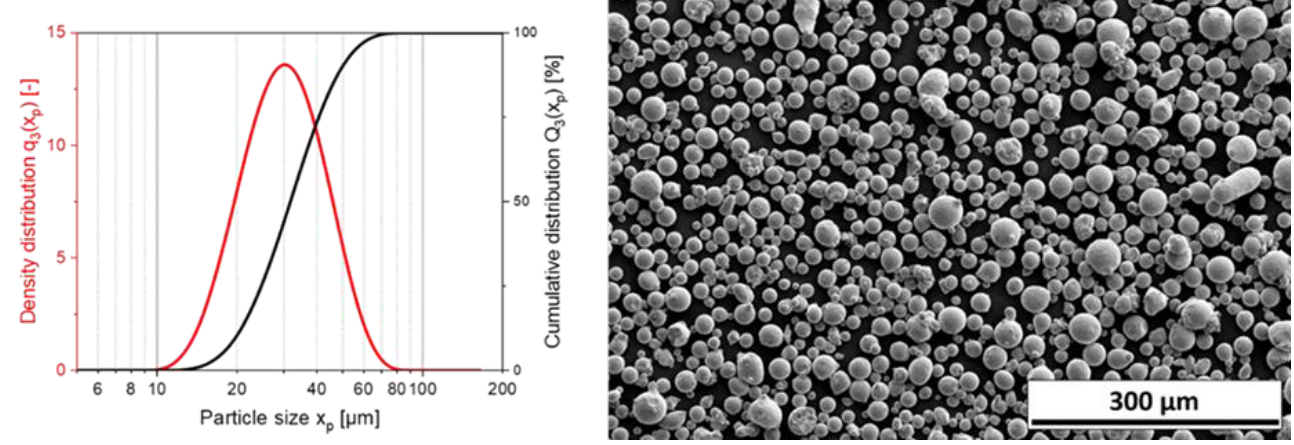
Figure 3. Feedstock powder 1.2709. Particle size distribution ( left ) SEM-picture at 500× magnification ( right ).